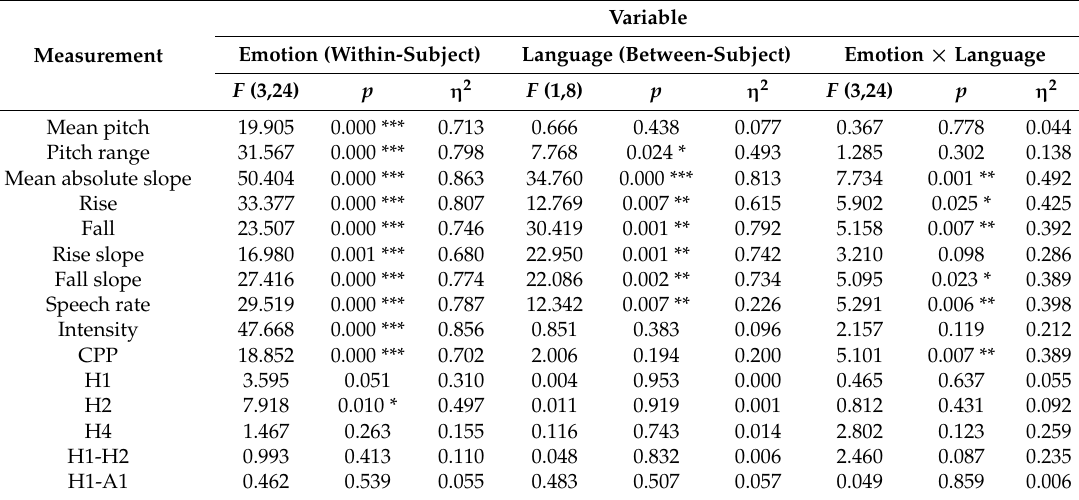
Table 4. Results of mixed repeated measures ANOVAs for each